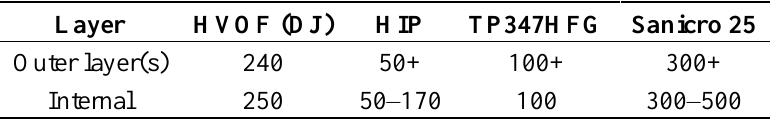
Figure 13. ( a ) SEM image of Sanicro 25 steel cross-section near the surface after the exposure at 720 °C for 1000 h; ( b ) EDX elemental map of the same area. Table 6. Corrosion layer thicknesses in μm at 720 °C. Some of the external corrosion layers had spalled off, indicated by the “+” signs. The HVOF coating was exposed for 700 h while the others were exposed for 1000